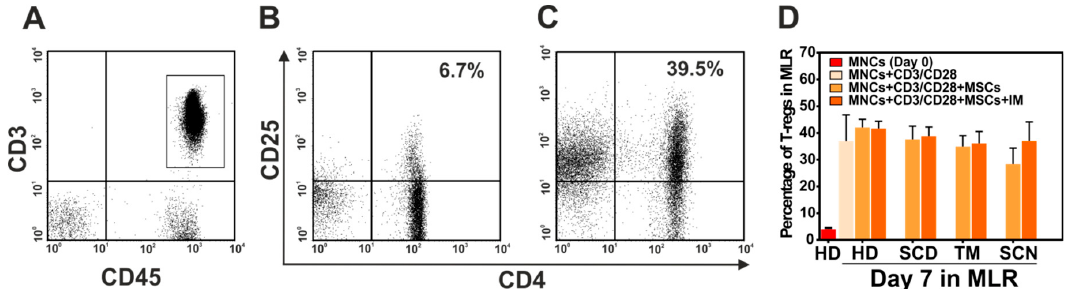
Figure 6. T-regulatory cells in mixed lymphocyte reaction MLR with MSCs of patients with non-malignant hematological diseases and healthy donors. ( A ) Dotplot of CD3+CD45+ T cells which were determined by flow cytometry after staining of mononuclear cells with anti-CD45 / CD3 / CD4 / CD25 antibodies on day 0 in MLR. ( B ) Percentage of CD24 + CD25 + cells after gating on CD45 + CD3 + lymphocytes on day 0 and 7 ( C ). ( D ) The percentage of T-regs in each study group on day 7 of MLR. HD: healthy donors; SCD: sickle cell disease; TM: thalassemia major; SCN: severe congenital